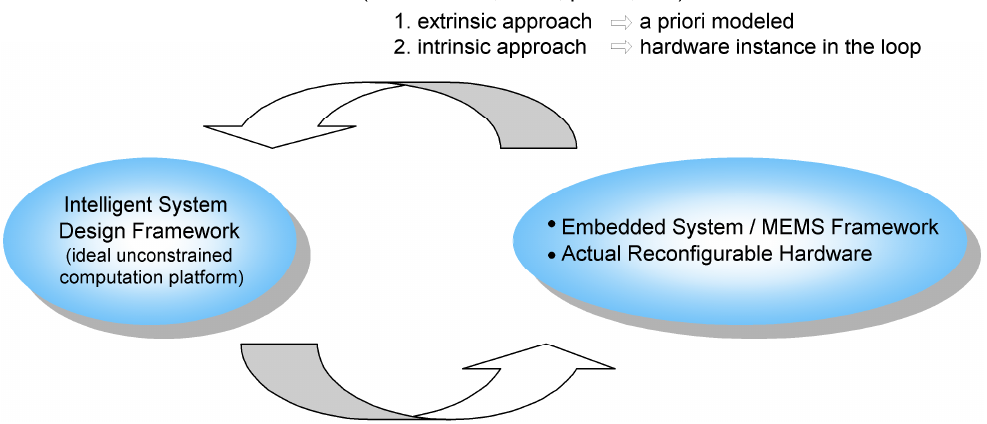
Figure 5. Feedback of hardware platform related constraints in the design process.